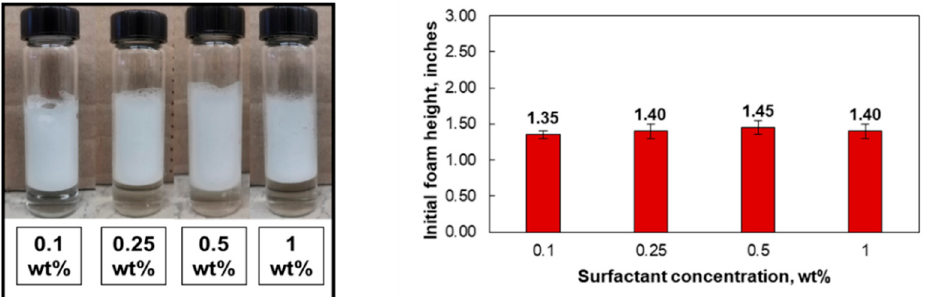
Figure 5. Effect of surfactant concentration on the initial foamability at 5 wt% NaCl, pH 6.5, and 77 °F (25 °C). Figure 6. Effect of surfactant concentration on the initial foamability at 20 wt% NaCl, pH 6.5, and 77 °F (25 °C).